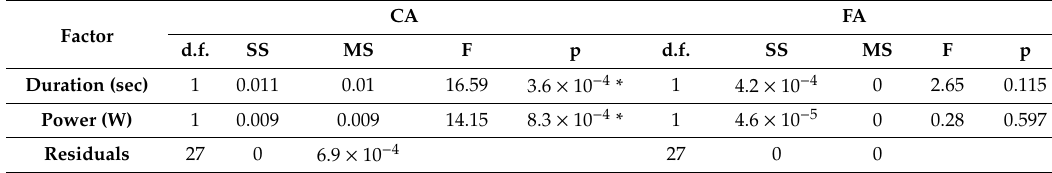
Table 5. ANOVA parameters to the significant e ff ects on FA and CA extraction depending on treatment duration (sec) and power (W). Phenolic acid analysis in duplicate for each test